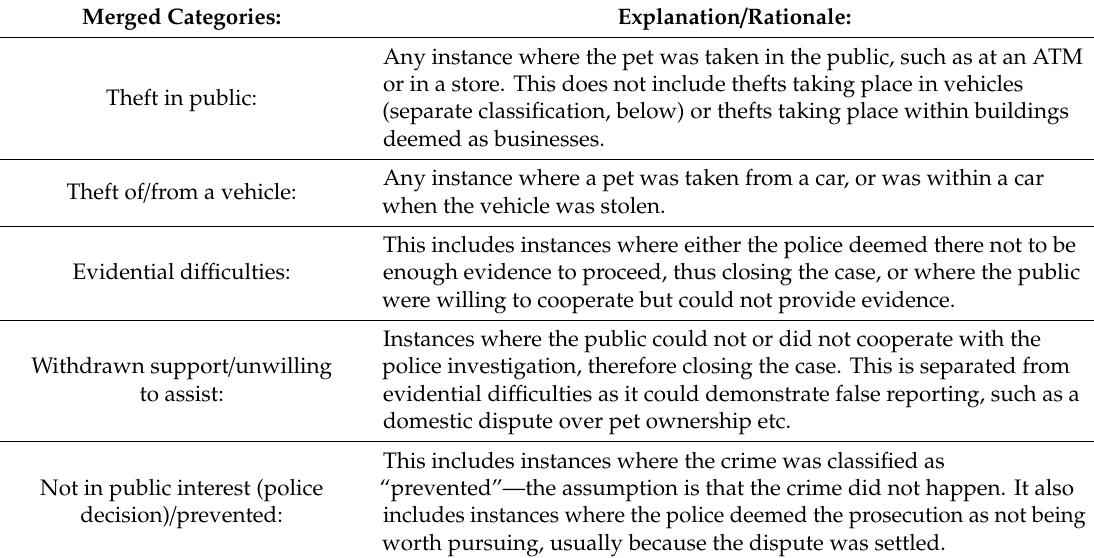
Table 1. Any “merged” categories that were made during the data sorting process. These were rational decisions made to manage the data given the vast di ff erences between how the data are recorded or how they were presented to